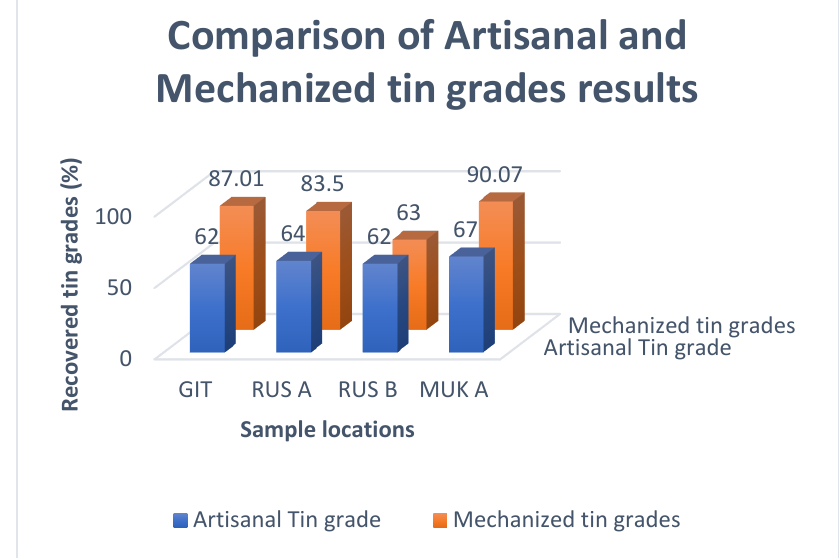
Figure 7. Comparison between tin grades from artisanal and mechanized recovery.